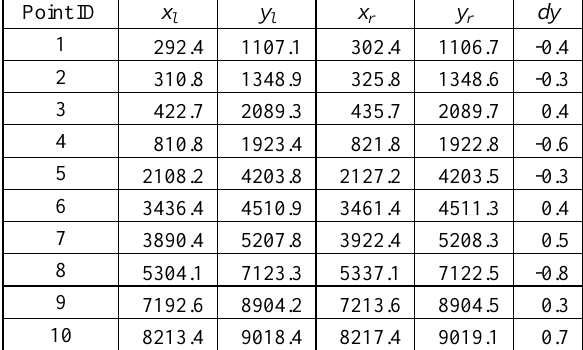
Figure 4. Experiment results Table 1. Y papallex of corresponding points